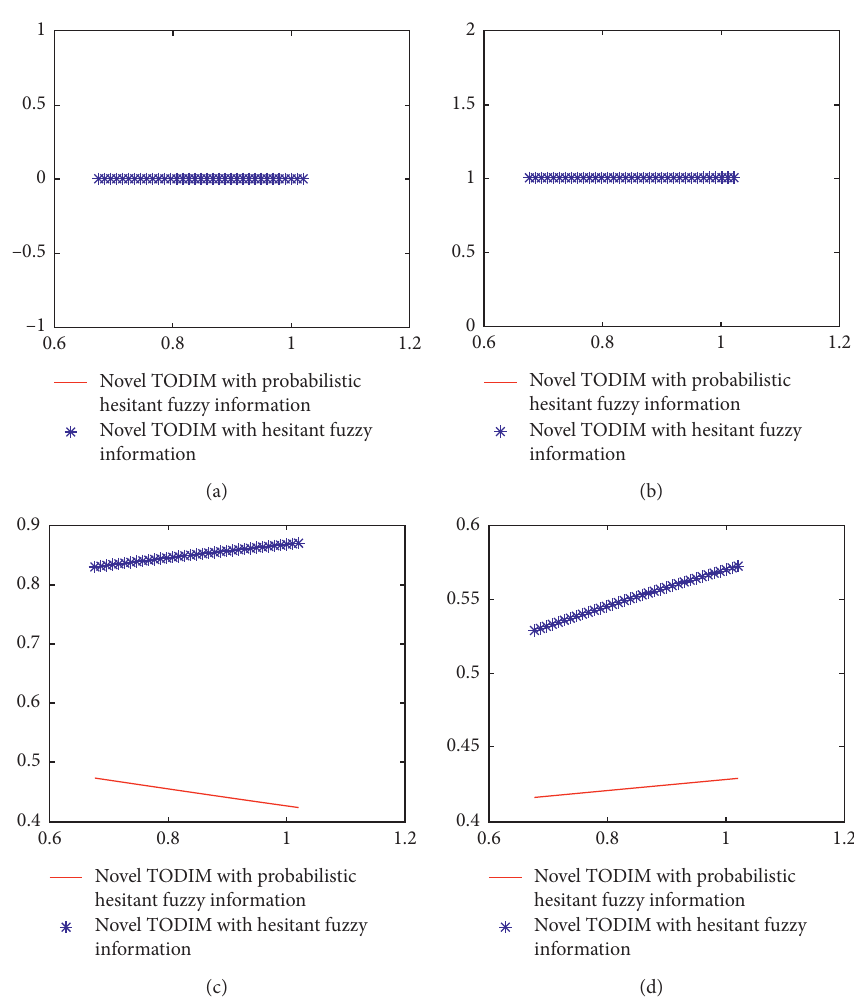
Figure 6: Sensitivity analysis of novel TODIM by changing β . 0 . 68 ≤ β ≤ 1 . 02, α � 0 . 88, δ � 0 . 69, c � 0 . 61, and λ � 2 . 25. (a) A (d) A 4 .